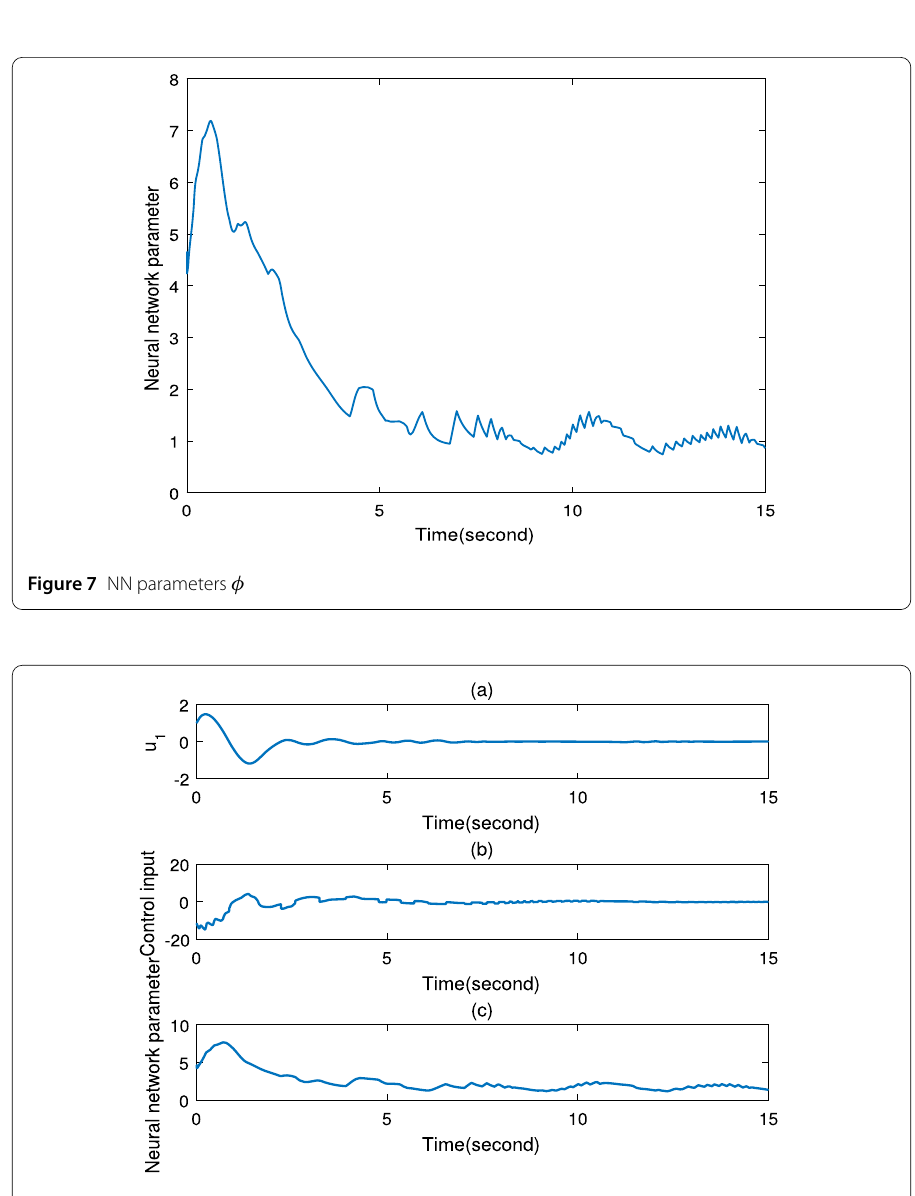
Figure 8 Simulation trajectories of system (12) with external